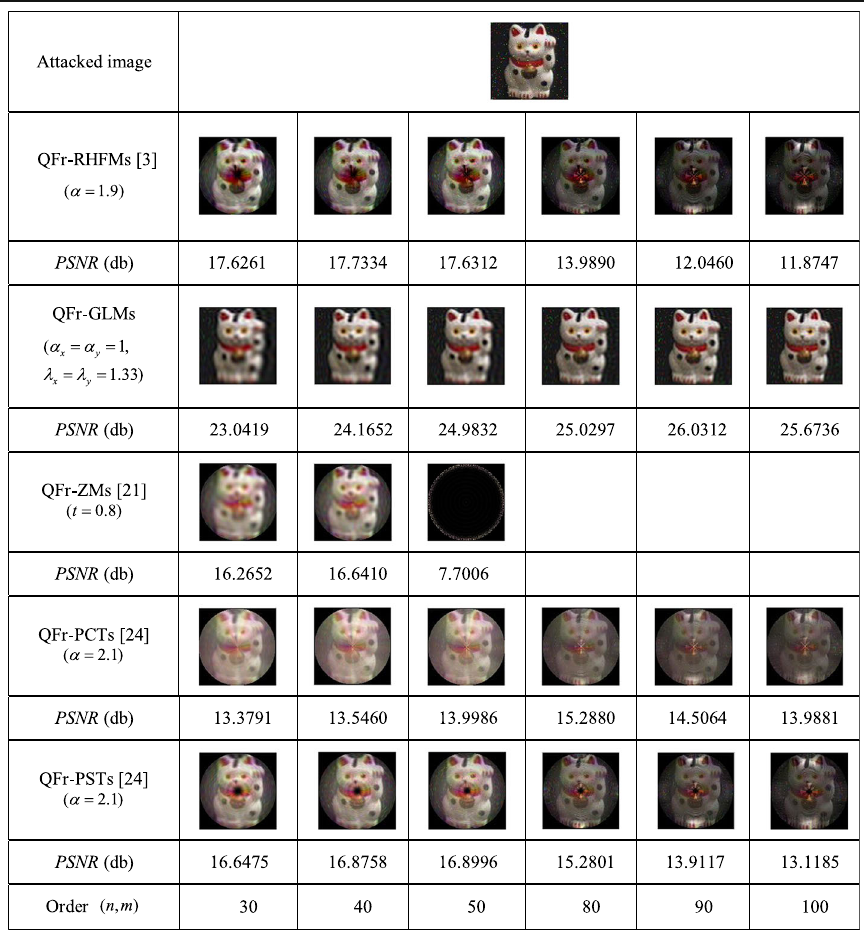
Table 3 Reconstruction performance comparison of different color-image in higher-order moments (under salt and pepper noise condition, noisy density =